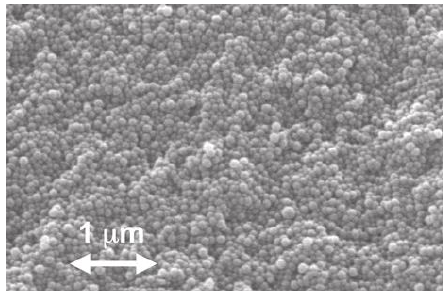
Figure 1. The Scanning Electron Microscopy (SEM) image of the colloidal silica abrasive grains, average size 100 nm. size 100